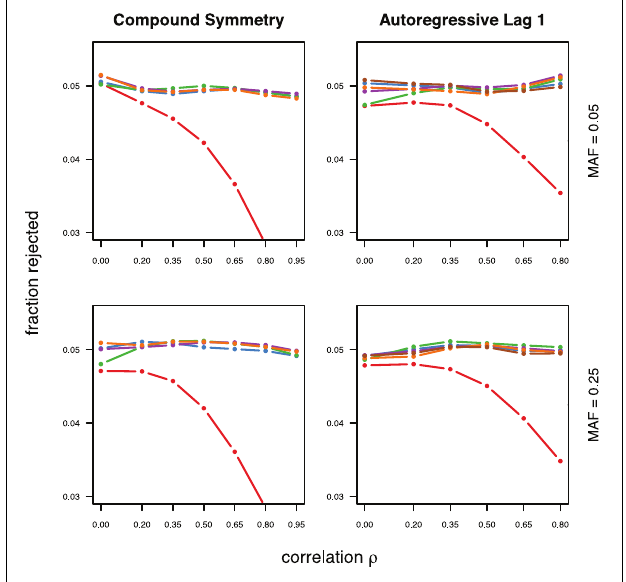
FIGURE 1 | Calibration under the null hypothesis for compound symmetry (left) and auto-regressive (right) correlation structures, assuming equal minor allele frequencies of 5% (top) and 25% (bottom) in a block of 5 markers. The fraction of rejected null hypotheses of no association (estimated type I error, y-axis) simulated in 50,000 data sets each is shown as a function of the between-marker correlation (x-axis). Each line represents a different method (see the following figures for details), with the Bonferroni method (red) showing the sharp decline as ρ